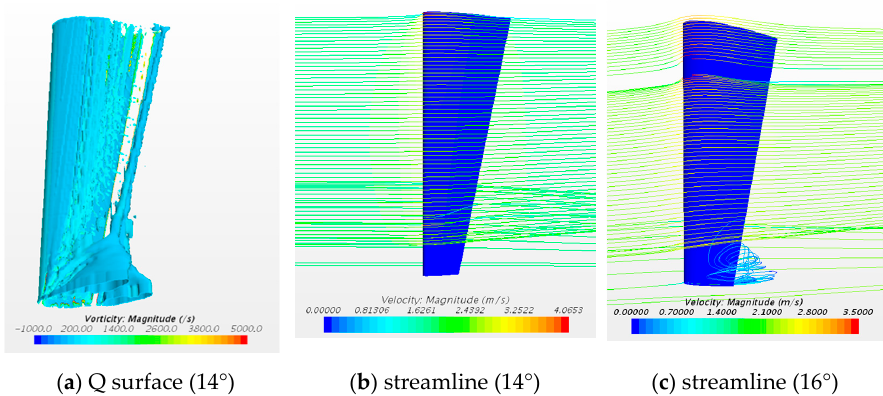
Figure 10. Vortex structures and streamlines near the surface of the base blade at small attack angles (the iso-surfaces in ( a ) corresponds to Q = 150, the streamline with the attack angle 14° in ( b ) and the streamline with the attack angle 16° in ( c )).